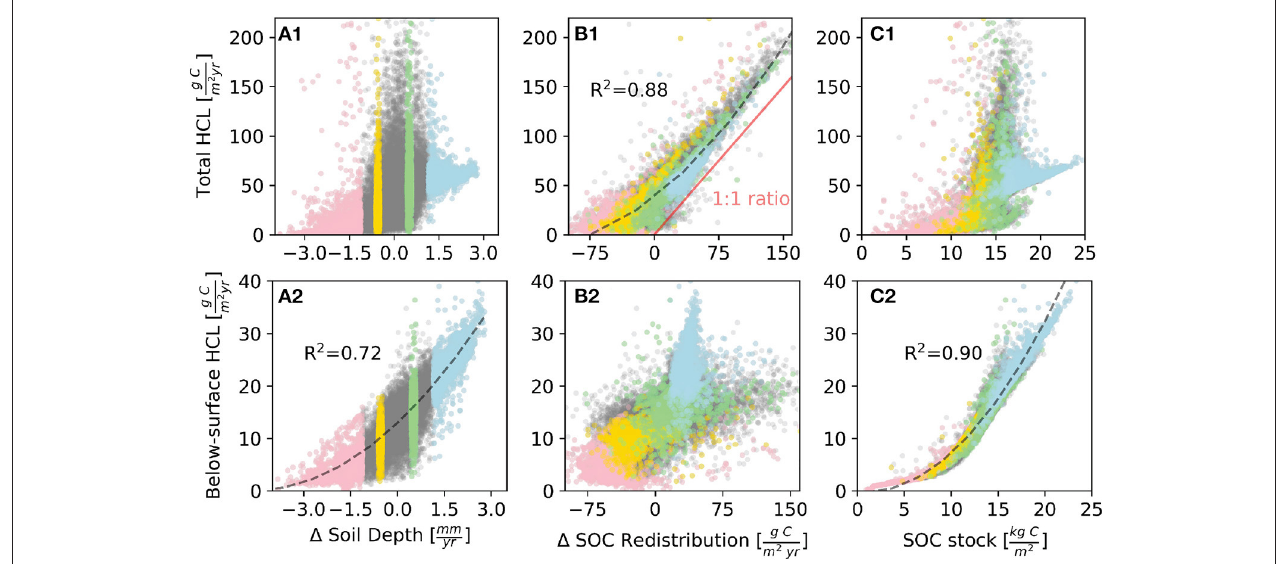
FIGURE 3 | The relationship between heterotrophic carbon loss (HCL), soil thickness change rate, SOC redistribution rate, and SOC stock at each 2-D grid box with annual mean values from years 85 to 90, which is within a period of dynamic steady-state. A positive value means deposition, and vice-versa for erosion. The red, yellow, green, and blue dots correspond to 5% areas of fast erosion areas (Zone A), moderate erosion areas (Zone B), moderate deposition areas (Zone C), and fast depositional areas (Zone D), respectively ( Figure 2a ). (A1–C1) The total HCL vs. other variables. (A2–C2) The below-surface HCL vs. other variables. The fitting curves (dash lines) are second-order polynomial fitting for (A1,A2,C2) . The corresponding R 2 values are labeled next to the curves.